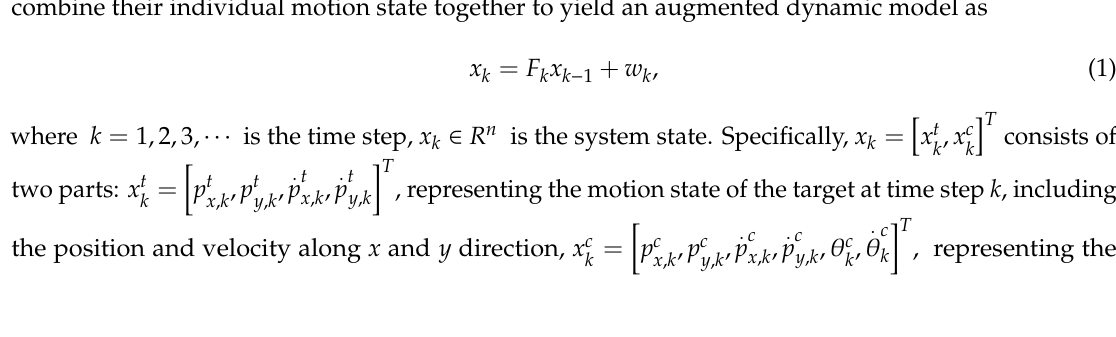
Figure 1. Schematic diagram of cooperative tracking scene (HV: host vehicle, CV: cooperative vehicle).